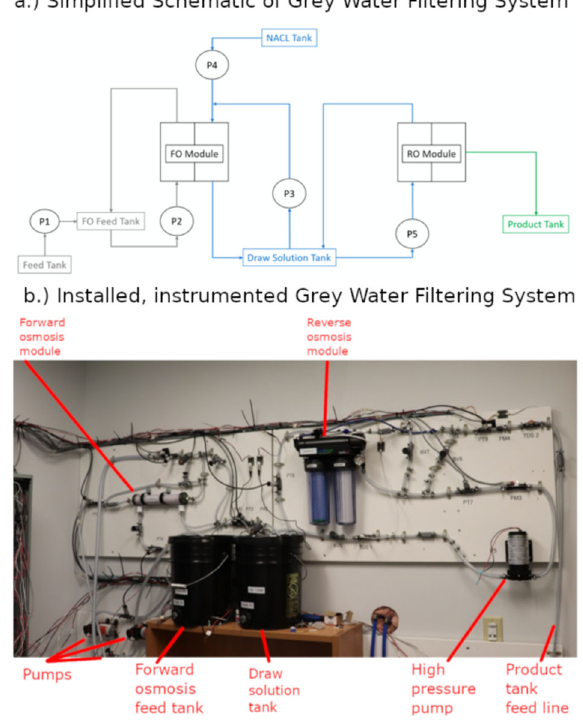
Fig. 2 In the grey water fi ltering system (GWS), grey water is sourced from a feed tank, fi ltered through a forward osmosis (FO) module, fi ltered through a reverse osmosis (RO) module, and fi nally fed into the product tank as potable water. a A simpli fi ed schematic illustrates the operation of the GWS. Essentially, there are 3 loops in which water fl ows. The FO and RO modules are key components. b The GWS was mostly assembled, installed, and instrumented on one wall within the mock space habitat. The GWS ’ s feed tank (left) and product tank (right) are out of view in this picture. (The annotated picture is provided by PacMar Technologies and used with